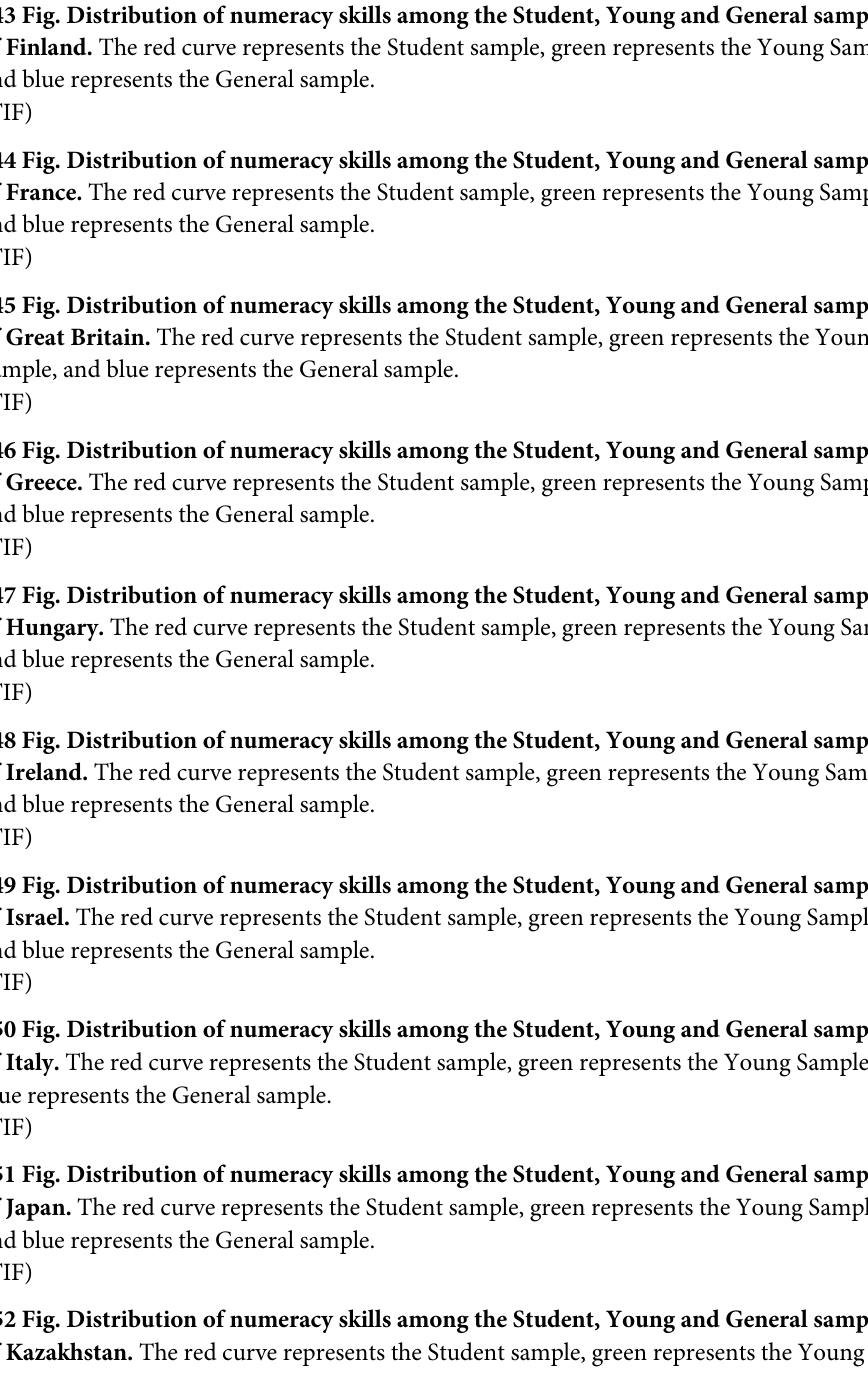
S42 Fig. Distribution of numeracy skills among the Student, Young and General samples of Estonia. The red curve represents the Student sample, green represents the Young Sample, and blue represents the General sample. (TIF) S43 Fig. Distribution of numeracy skills among the Student, Young and General samples of Finland. The red curve represents the Student sample, green represents the Young Sample, and blue represents the General sample. (TIF) S44 Fig. Distribution of numeracy skills among the Student, Young and General samples of France. The red curve represents the Student sample, green represents the Young Sample, and blue represents the General sample. (TIF) S45 Fig. Distribution of numeracy skills among the Student, Young and General samples of Great Britain. The red curve represents the Student sample, green represents the Young Sample, and blue represents the General sample. (TIF) S46 Fig. Distribution of numeracy skills among the Student, Young and General samples of Greece. The red curve represents the Student sample, green represents the Young Sample, and blue represents the General sample. (TIF) S47 Fig. Distribution of numeracy skills among the Student, Young and General samples of Hungary. The red curve represents the Student sample, green represents the Young Sample, and blue represents the General sample. (TIF) S48 Fig. Distribution of numeracy skills among the Student, Young and General samples of Ireland. The red curve represents the Student sample, green represents the Young Sample, and blue represents the General sample. (TIF) S49 Fig. Distribution of numeracy skills among the Student, Young and General samples of Israel. The red curve represents the Student sample, green represents the Young Sample, and blue represents the General sample. (TIF) S50 Fig. Distribution of numeracy skills among the Student, Young and General samples of Italy. The red curve represents the Student sample, green represents the Young Sample, and blue represents the General sample. (TIF) S51 Fig. Distribution of numeracy skills among the Student, Young and General samples of Japan. The red curve represents the Student sample, green represents the Young Sample, and blue represents the General sample. (TIF) S52 Fig. Distribution of numeracy skills among the Student, Young and General samples of Kazakhstan. The red curve represents the Student sample, green represents the